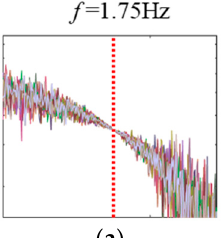
Figure 5. Transmissibility t 34 of response in a finite time period (20 groups).